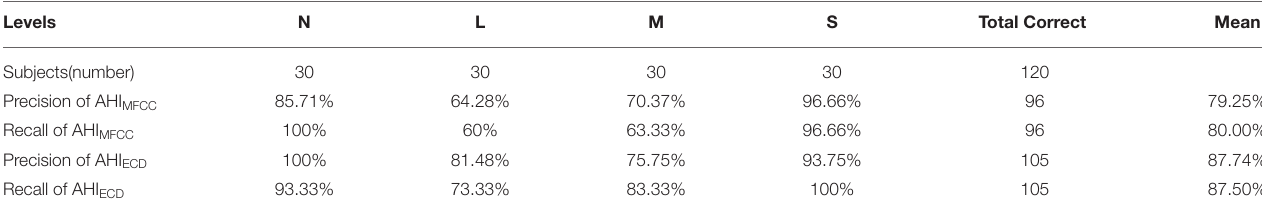
TABLE 2 | Precision and recall of AHI MFCC and AHI ECD compared AHI PSG .